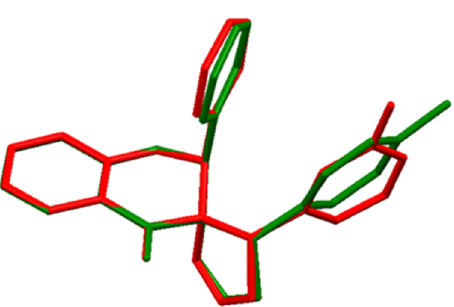
Figure 2. The molecular structure of compound I and II with displacement ellipsoids drawn at the 50% probability level.